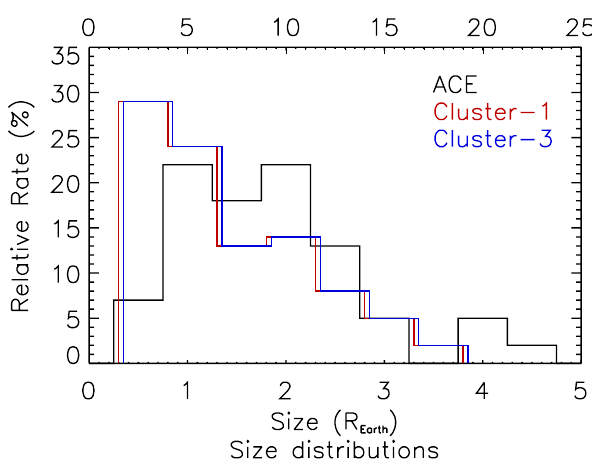
Fig. 5. The size distributions of HFAs estimated by Alfv´en veloc- ity and (solid line) the speed of the TD and bow shock intersection calculated by the solar wind measurements of Cluster-1 and -3 CIS HIA (red and blue line, scale drawn on top). The average sizes are ( 1 . 9 ± 1 . 0 ) R Earth , ( 7 . 0 ± 4 . 3 ) R Earth and ( 6 . 6 ± 4 . 2 ) R Earth , respec-